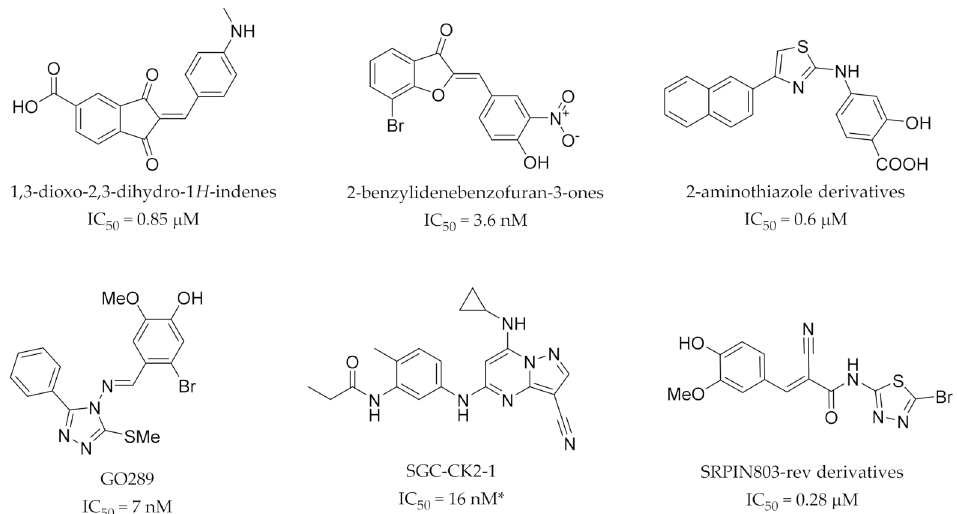
Figure 8. Structures of the most recently developed ATP-competitive CK2 inhibitors: 1,3-dioxo-2,3- dihydro-1H-indenes, 2-benzylidenebenzofuran-3-ones, 2-aminothiazoles, GO289, SGC-CK2-1 and SRPIN803-rev derivatives. *IC50 for SGC-CK2-1 is for CK2 α ’ [110–112,115–117]. Oshima et al. identified GO289 in 2019 through affinity-based target